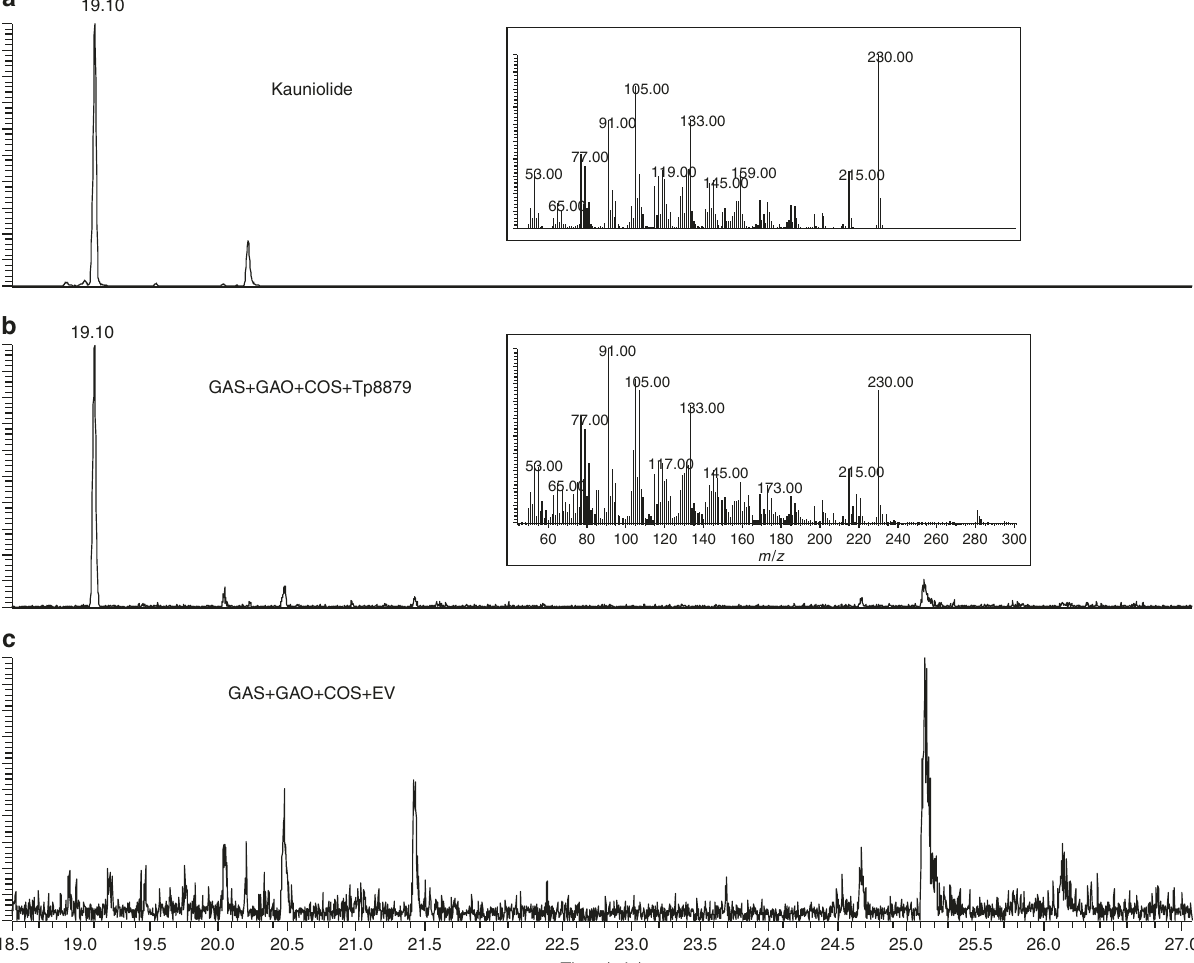
Fig. 6 Characterization of TpKLS and reconstitution of the kauniolide biosynthesis pathway in yeast. GC-MS chromatograms at nominal mass 230 of kauniolide. a Kauniolide standard. b Kauniolide production by expressing the costunolide biosynthetic pathway (TpGAS, TpGAO and CiCOS) in combination with Tp8879 (TpKLS). c Negative control. Expression of the costunolide biosynthetic pathway with EV (microsomes of yeast with empty vector) does not lead to formation of